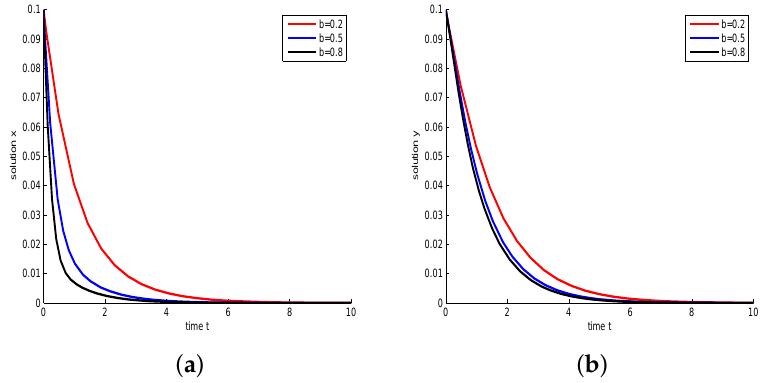
Figure 5. Take b = 0.2, b = 0.5, b = 0.8, respectively, and ( x ( 0 ) , y ( 0 )) = ( 0.1,0.1 ) . In this case, E 0 is a stable node. ( a ) Juvenile species. Numerical simulation of juvenile species x of Model (22). ( b ) Adult species. Numerical simulation of adult species y of Model (22).